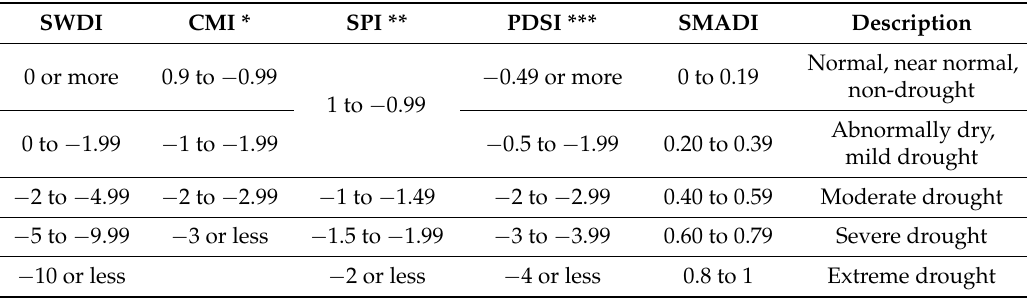
Table 4. Drought categories after several